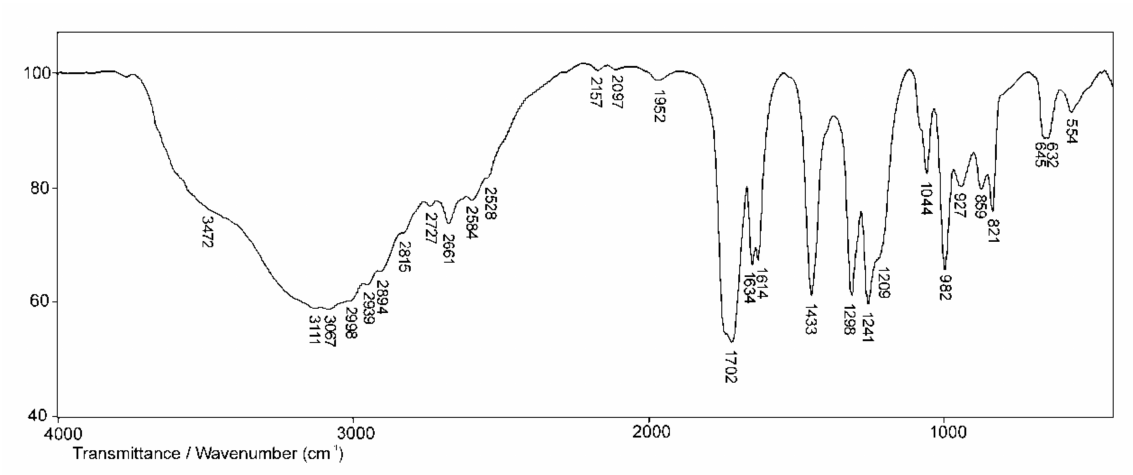
Figure 6. FTIR spectrum of the comonomer acrylic acid (AA). The FTIR spectrum of the synthesized copolymer p(NIPAM-co-AA) with 5 mol% of acrylic acid and 1.5 mol% of the cross-linker EGDM is shown in Figure 7.